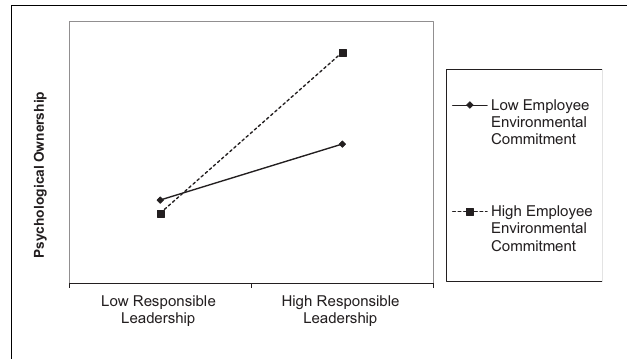
FIGURE 2 | Interaction